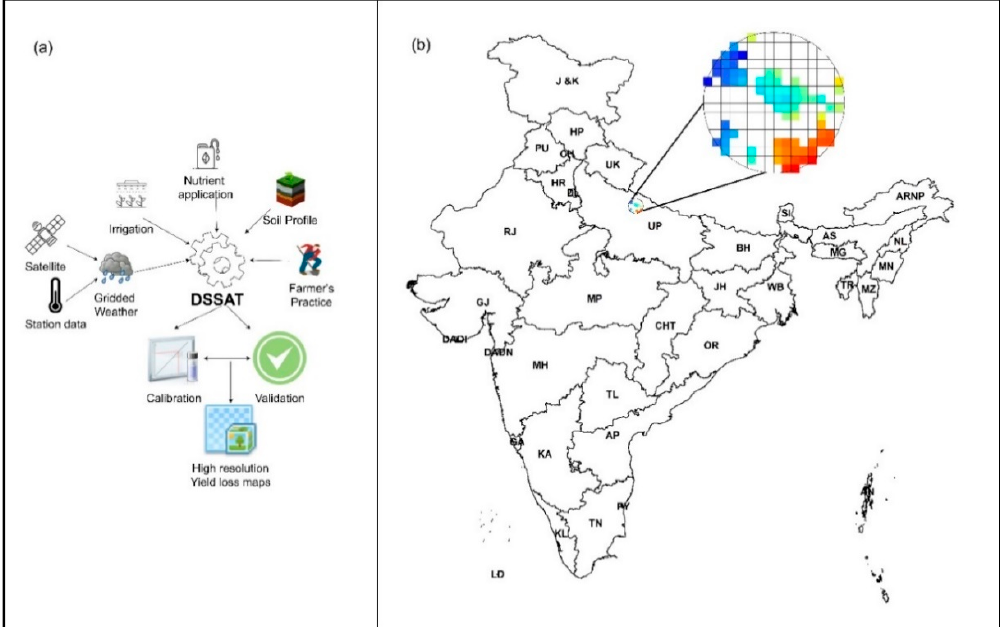
Figure 1. The workflow of the study ( a ) and state boundaries in India ( b ) with a sample of grid cells (diameter of the circle is approximately 100 km 2 ). The state acronyms are explained in Table S1.